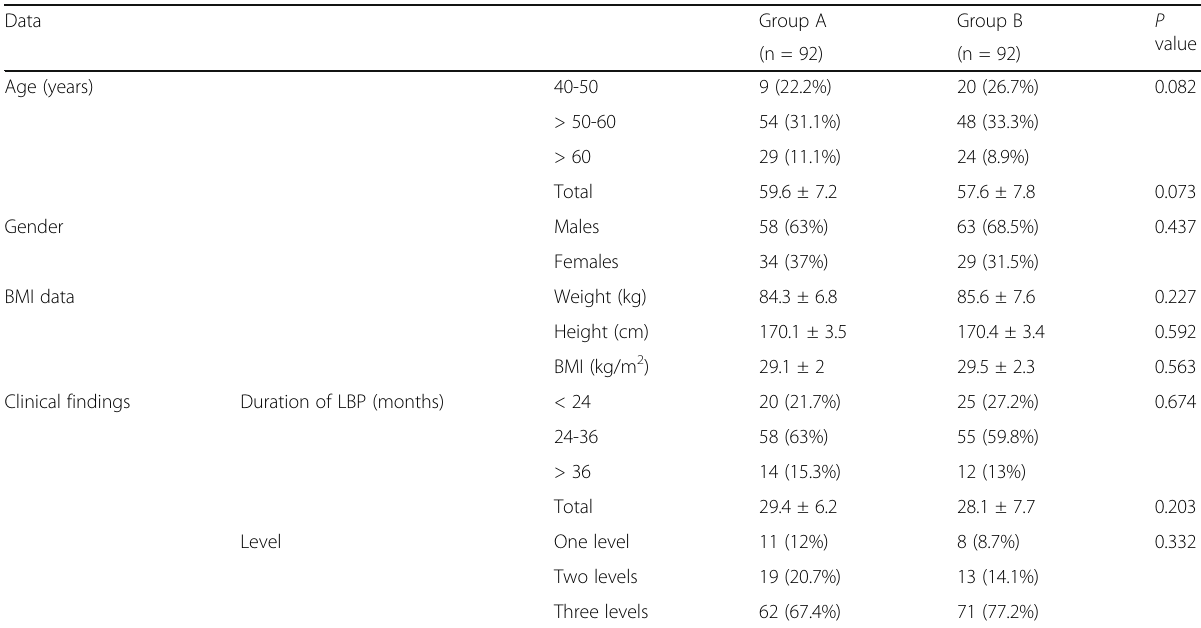
Table 1 Patients ’ enrollment data Data